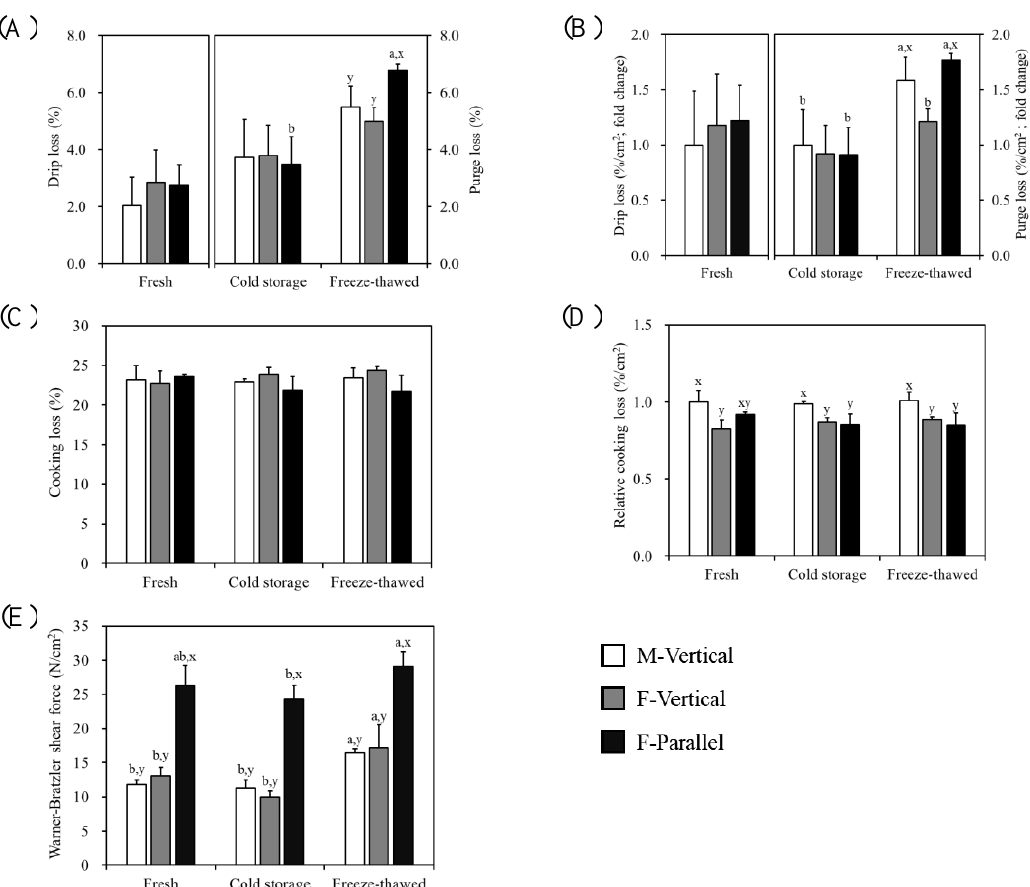
Figure 3. Comparison of water-holding capacity and tenderness of pork loin chops cut in different directions. ( A ) Drip loss of fresh chop and purge loss of aged or freeze–thawed chops. ( B ) Relative drip or purge losses per unit area of chop surface. ( C ) Cooking losses of fresh, aged, and freeze–thawed pork loin chops. ( D ) Relative cooking loss per unit area of chop surface. ( E ) Warner-Bratzler shear force of fresh, aged, and freeze–thawed pork loin chops. M-Vertical, cut vertical to the longitudinal direction of loin muscle; F-Vertical, cut vertical to the muscle fiber orientation; F-Parallel, cut parallel to the muscle fiber orientation. Different letters on the bar indicate significant differences between loin cut groups (x, y) or between storage methods (a, b) at p <